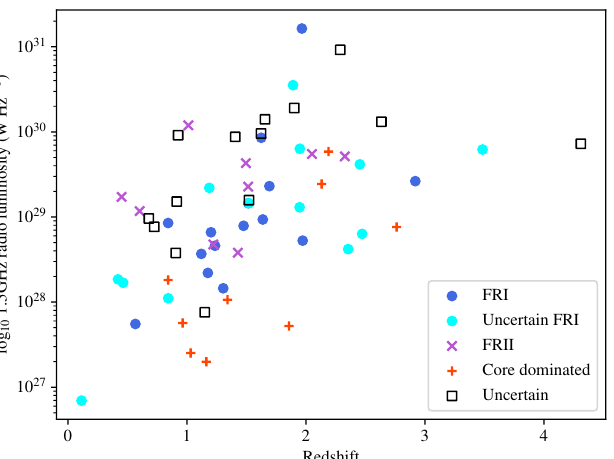
Figure 2. The distribution of 1.5-GHz VLA luminosity of quasars as a function of their redshifts. See Section 3.1 for the classification of sources. For a clean representation, we show FRII quasars and uncertain FRIIs using the same symbol.